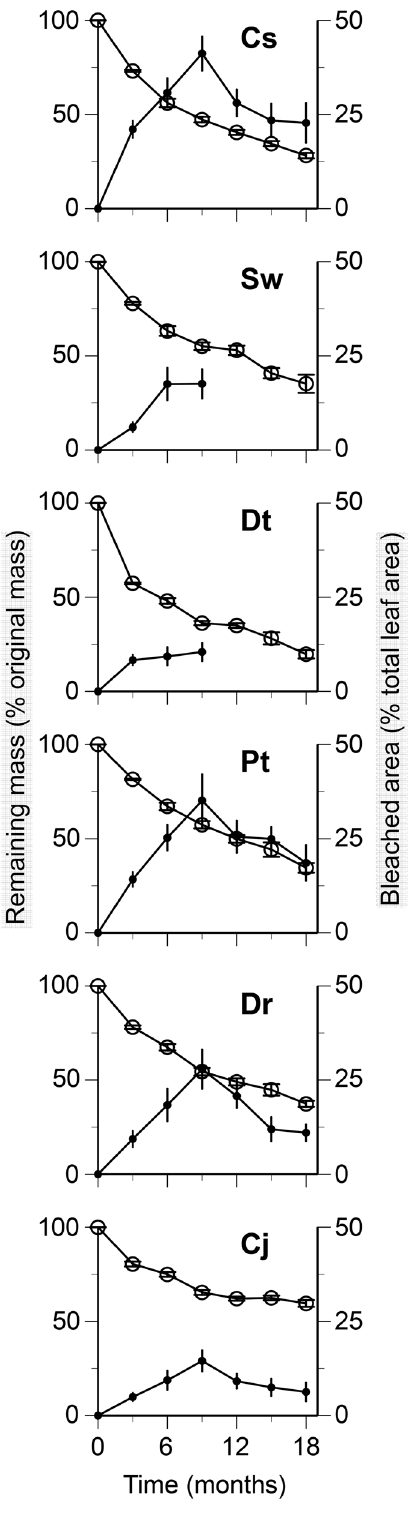
Figure 1. Changes in remaining mass (% original mass; left axis, open circle) and bleached area (% total leaf area; right axis, filled circle) during decomposition. Codes on the panels indicate the first letter of genus and species names of tree species. Bars indicate standard errors. No data were available for bleached area between 12 and 18 months in Schima wallichii and Daphniphyllum teijsmannii because of fragmentation of leaf